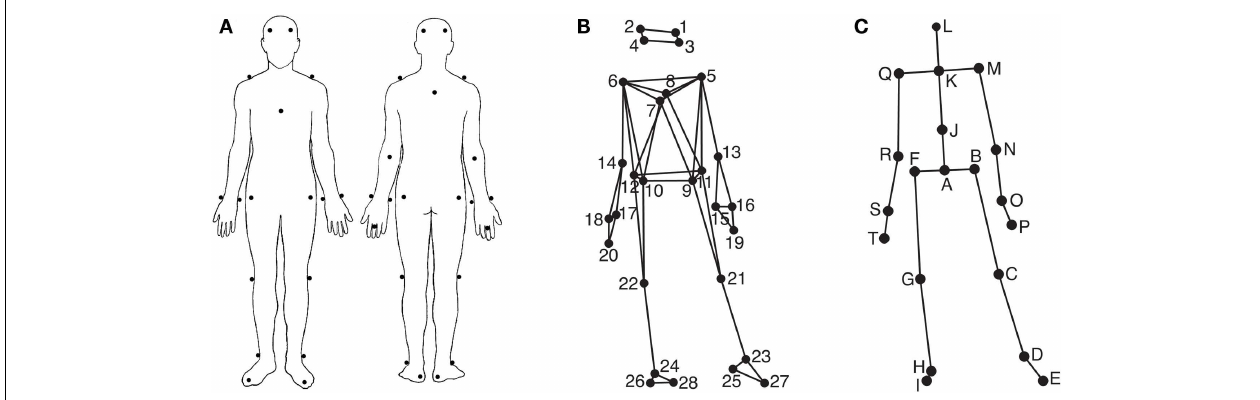
FIGURE 1 | Marker and joint locations. (A) Anterior and posterior view of the marker placement on the participants’ bodies; (B) Anterior view of the marker locations as stick figure illustration; (C) Anterior view of the locations of the secondary markers/joints used in the analysis.